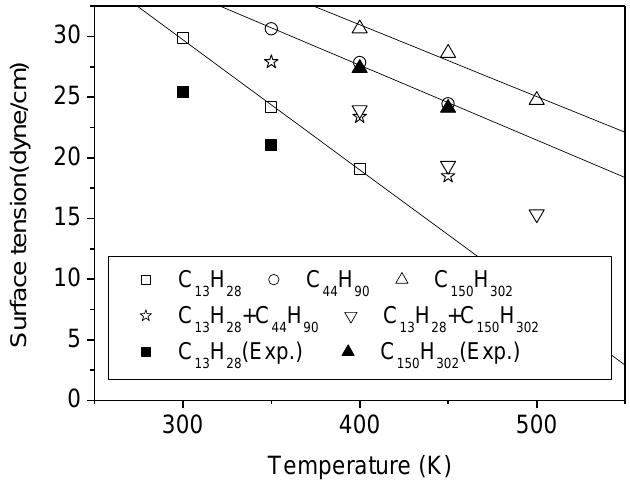
Figure 2. Surface tensions of polyethylene films. The open symbols are obtained from molecular dynamics (MD) simulation and the closed symbols are experimental results from references [36,37]. The simulation results of C 13 H 28 are taken from Chang et al. [3]. Table 1. The surface tension of polyethylene films obtained from molecular dynamics simulations. The unit is dyn/cm. Temp. (K)